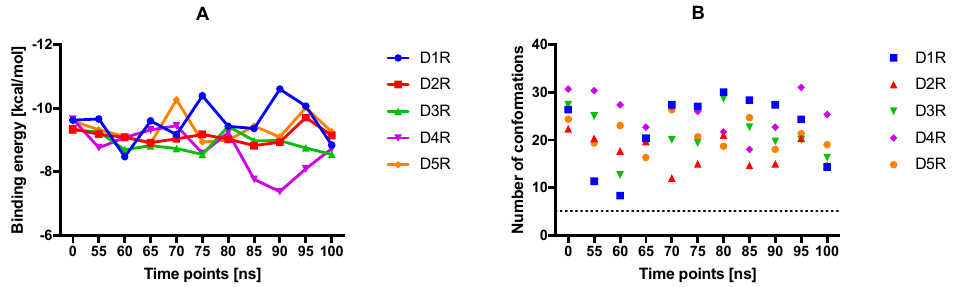
Figure 3. Results of the molecular docking of dopamine to all DR subtypes at all MD time steps. ( A ) The average binding energy of the three lowest energies of dopamine was calculated. ( B ) The mean of the number of conformations of the three clusters with the lowest binding energies are shown for each time point and receptor.